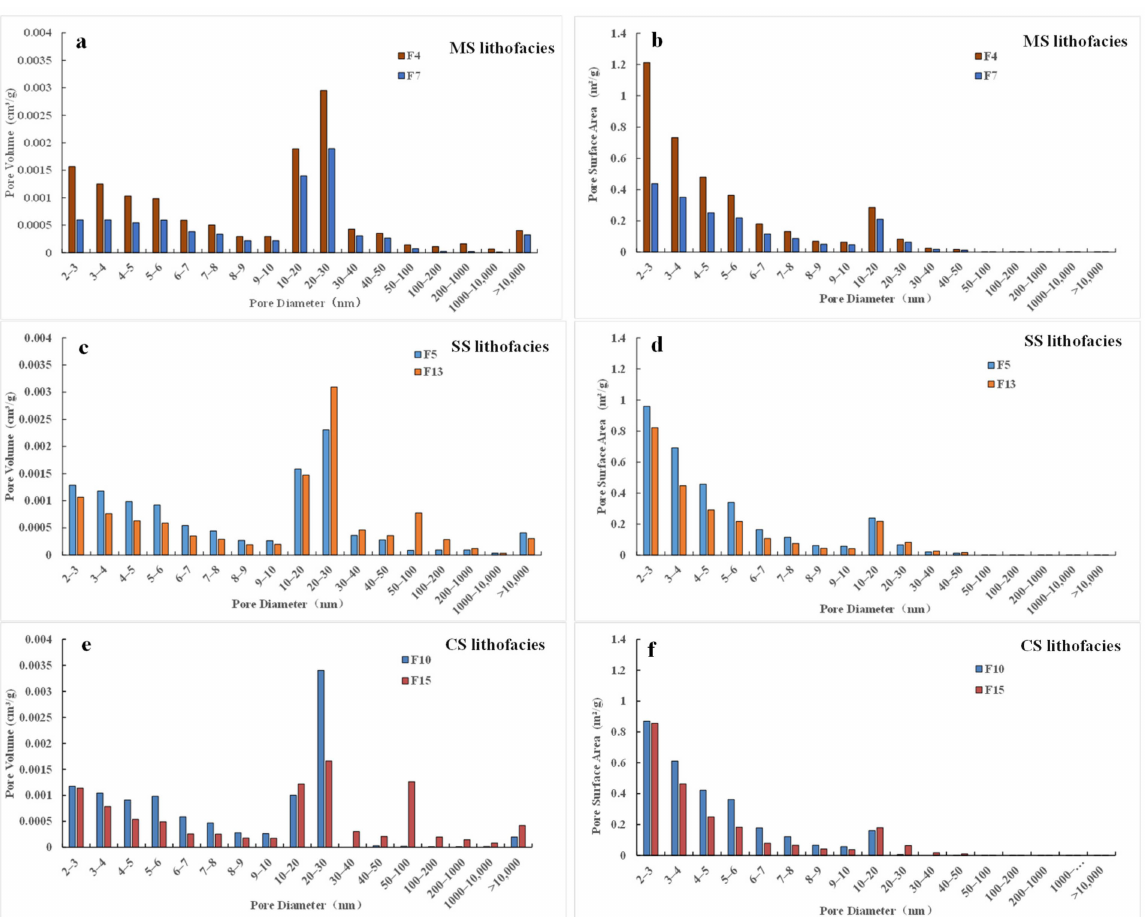
Figure 6. Pore volume and surface area distribution of the Funing Formation shale samples: ( a ) PV of distribution of the MS lithofacies; ( b ) SSA of distribution of the MS lithofacies; ( c ) PV of distribution of the SS lithofacies; ( d ) SSA of distribution of the SS lithofacies; ( e ) PV of distribution of the CS lithofacies; ( f ) SSA of distribution of the CS